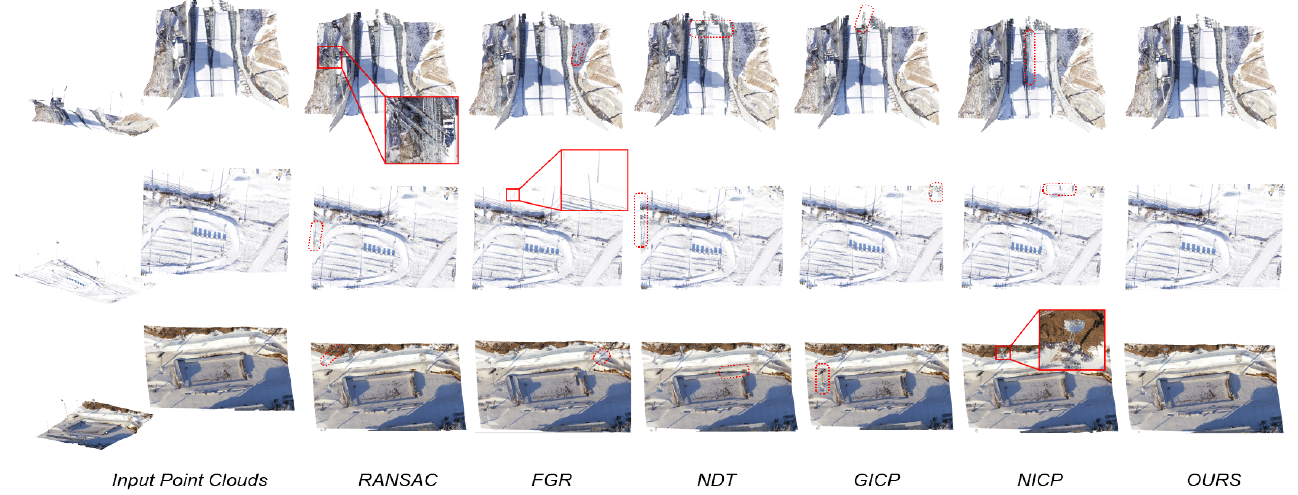
Figure 11. Comparison of registration effects for self-built data.On samples selected from self-built databases (SJC, CSC, and BSC), we performed point cloud registration tests using RANSAC, FGR, NDT, GICP, NICP, and our proposed method. There are two types of boxes in the figure: the dotted box represents the place where there is obvious registration deviation, and the solid rectangle represents an enlarged view of the local deviation.